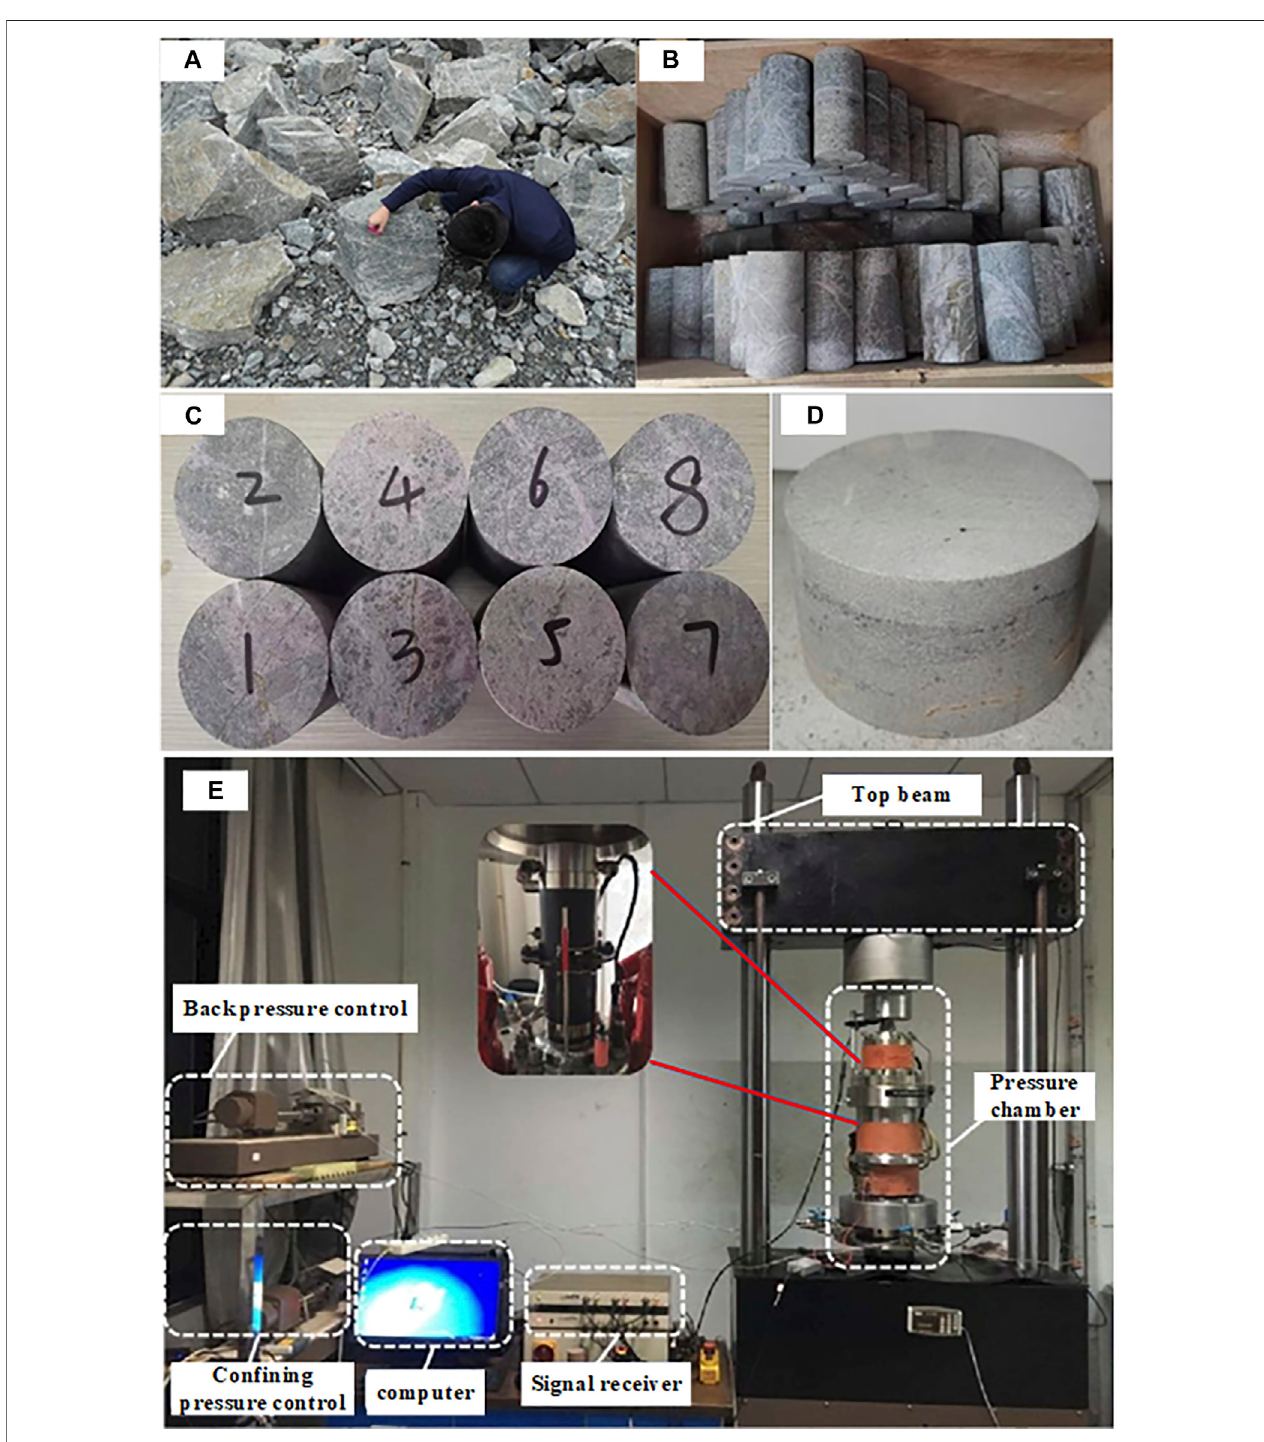
FIGURE 2 | (A) On-site sampling; (B) on-site rock samples; (C) standard cylindrical specimen; (D) standard Brazil split specimen; (E) GDS-VIS uniaxial and triaxial compression machine.